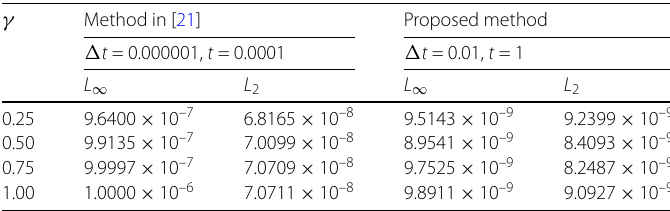
Table 3 Comparison of absolute errors for Problem 2 when n = 100 γ Method in [21]